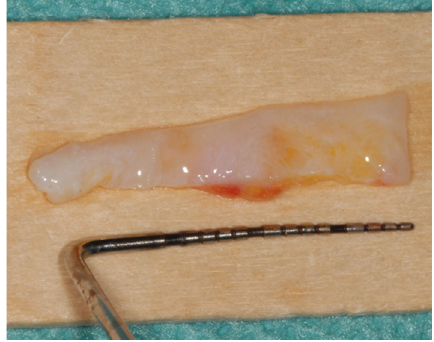
Figure 8: Second part of the second deepithelialized free gingival graft.